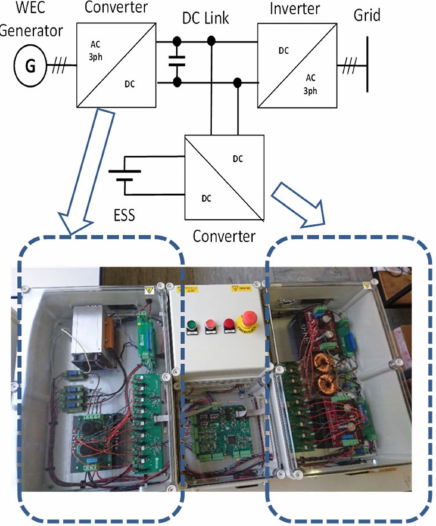
Figure 9. Voltage source converter schematic and hardware.